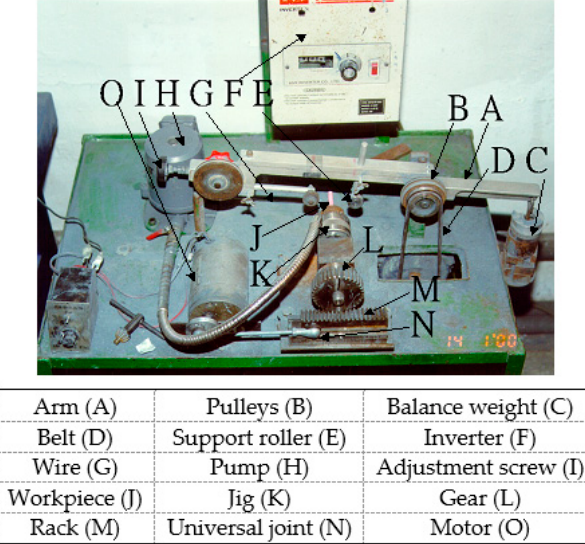
Figure 1. Setup for the single wire-saw system.